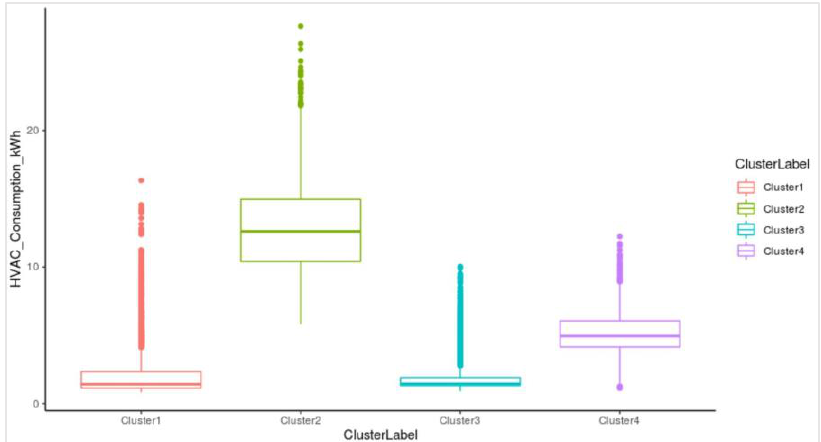
Figure 11. HVAC consumption per cluster label.